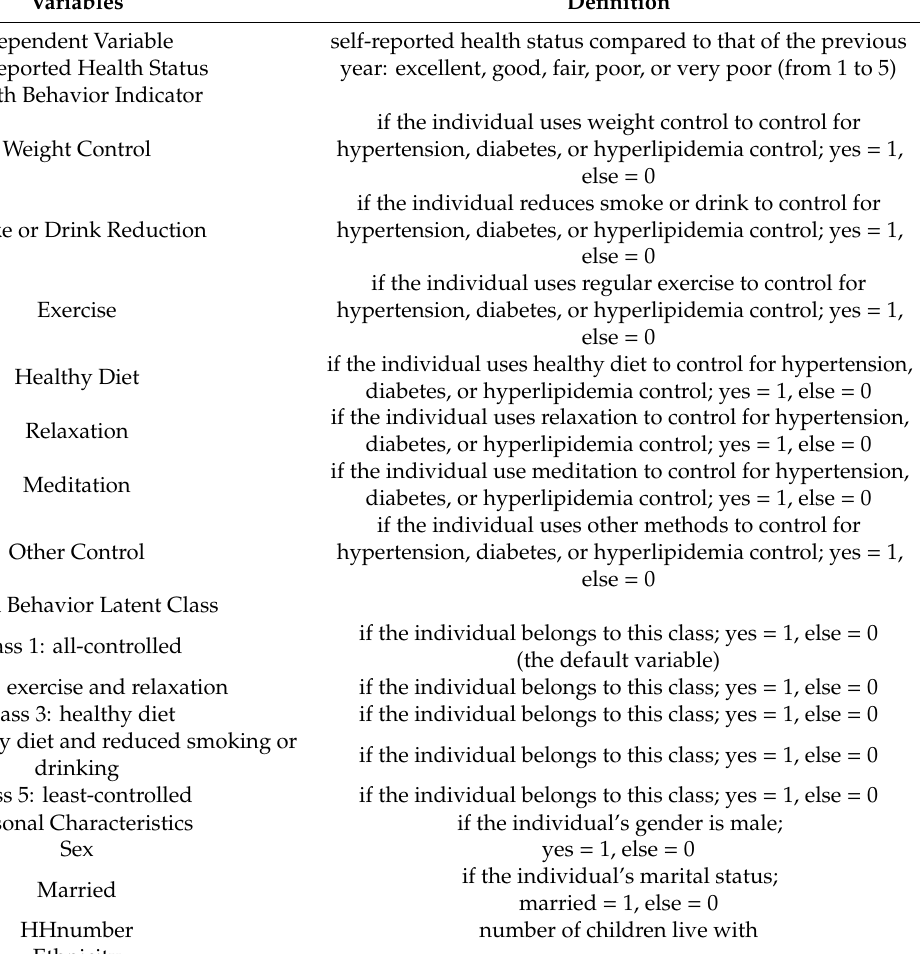
Table 2. Definitions of the studied